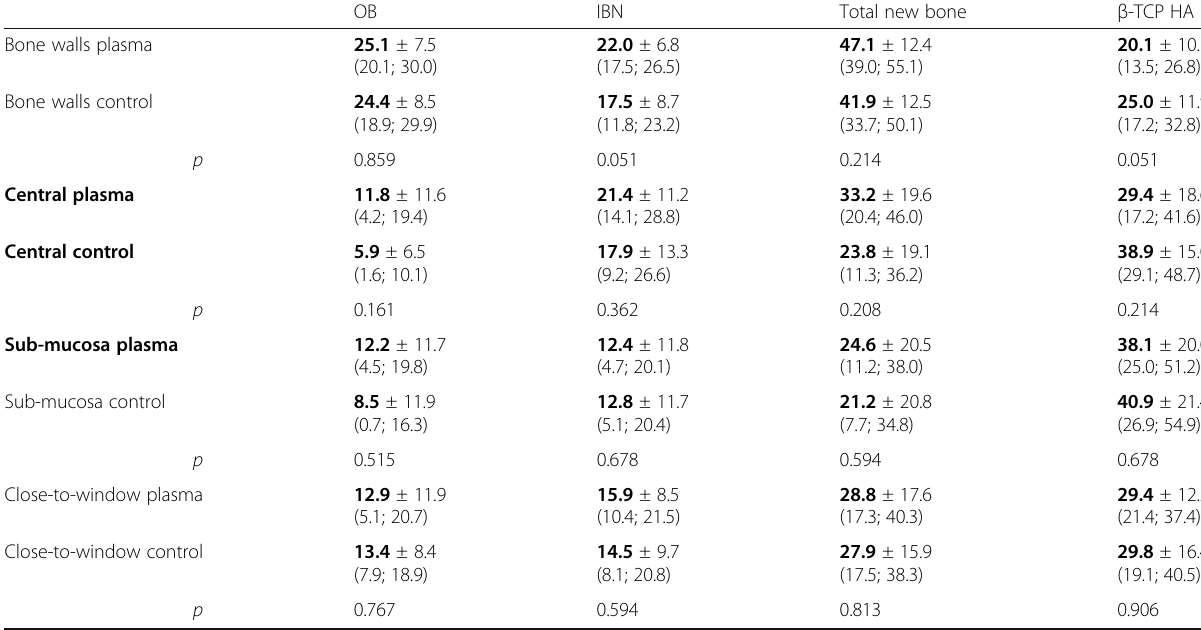
OB outer bone, INB interpenetrating bone network. Total new bone = OB + INB. β -TCP HA residual alloplastic graft None of the difference was statistically